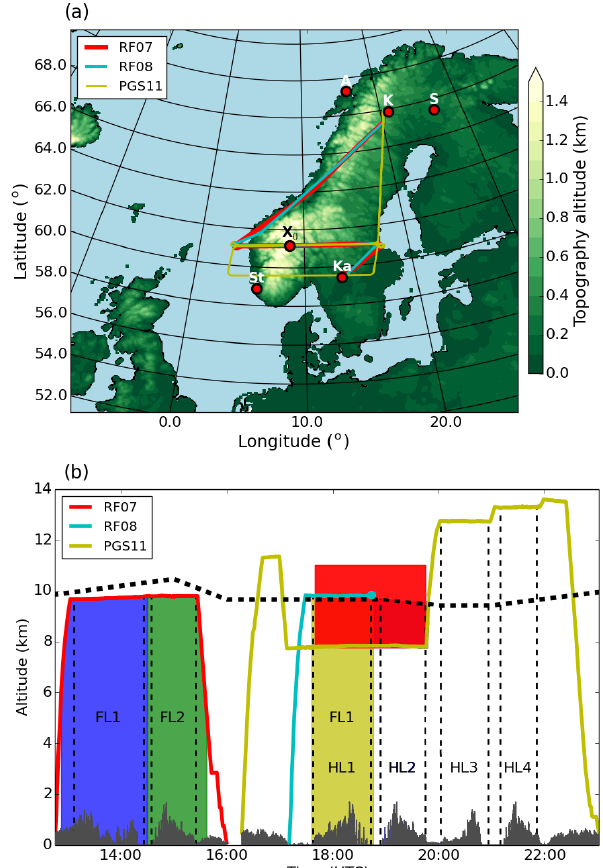
Figure 1. (a) Topographic map of Scandinavia and area of opera- tion of IOP 6 during the GW-LCYCLE II campaign. The coloured lines indicate Falcon (RF07 and RF08) and HALO (PGS11) flight tracks. The red dots mark the position of Andenes (A), Kiruna (K), Sodankylä (S), Karlstad (Ka) and Stavanger (St). The location of the highest mountain peak on the cross-mountain flight legs is marked with X 0 . Flight altitudes of Falcon and HALO are shown in panel (b) . Falcon flight legs RF07 FL2 and RF08 FL1 and HALO flight legs PGS11 HL1, HL2 and HL4 are cross-mountain flights through X 0 , which are analysed in this study. Colour shaded areas mark regions covered by the upward-looking HALO water vapour lidar WALES (red) and the downward-looking Falcon Doppler wind lidar in scanning (blue), nadir (green) and flux mode (yellow). The temporal evolution of the ECMWF thermal tropopause height at point X 0 is indicated with the thick dashed line.